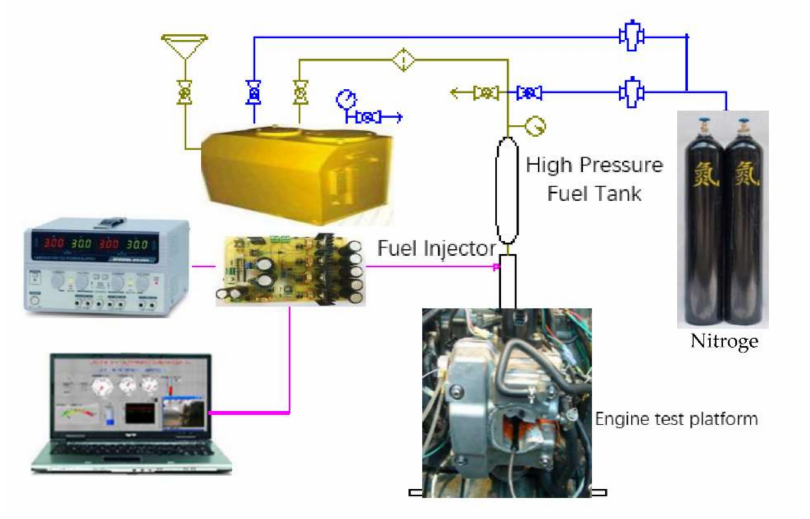
Figure 13. Experimental high-pressure fuel